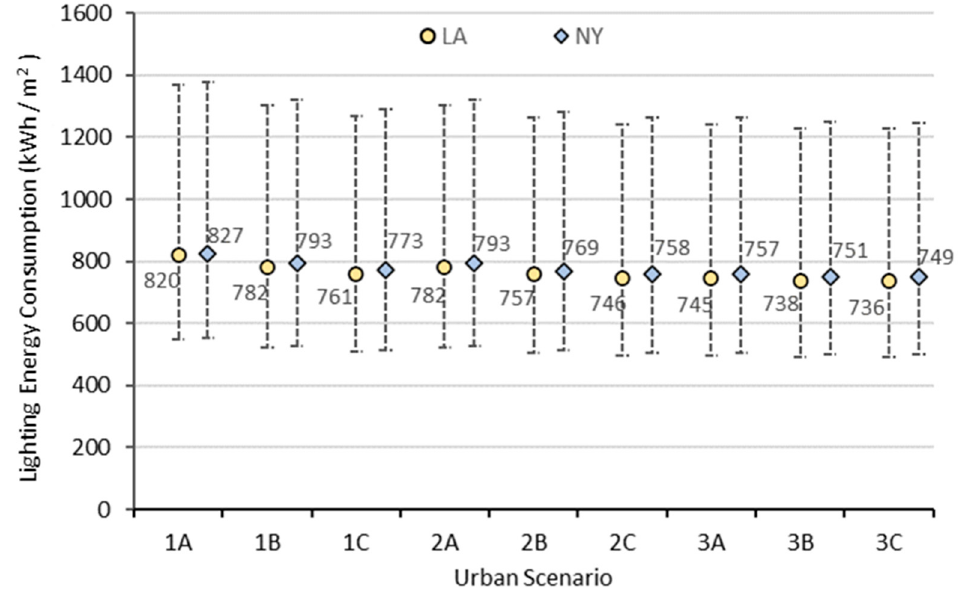
Figure 7. Annual lighting energy use index (kWh · m − 2 ) of nine urban settings (described in Table 3) for New York (NY) and Los Angeles (LA). The error bars represent the lighting energy consumption for different assumptions using PAR efficacy of 3 µmol J − 1 (lower bar) and 1.2 µmol J − 1 (upper bar).